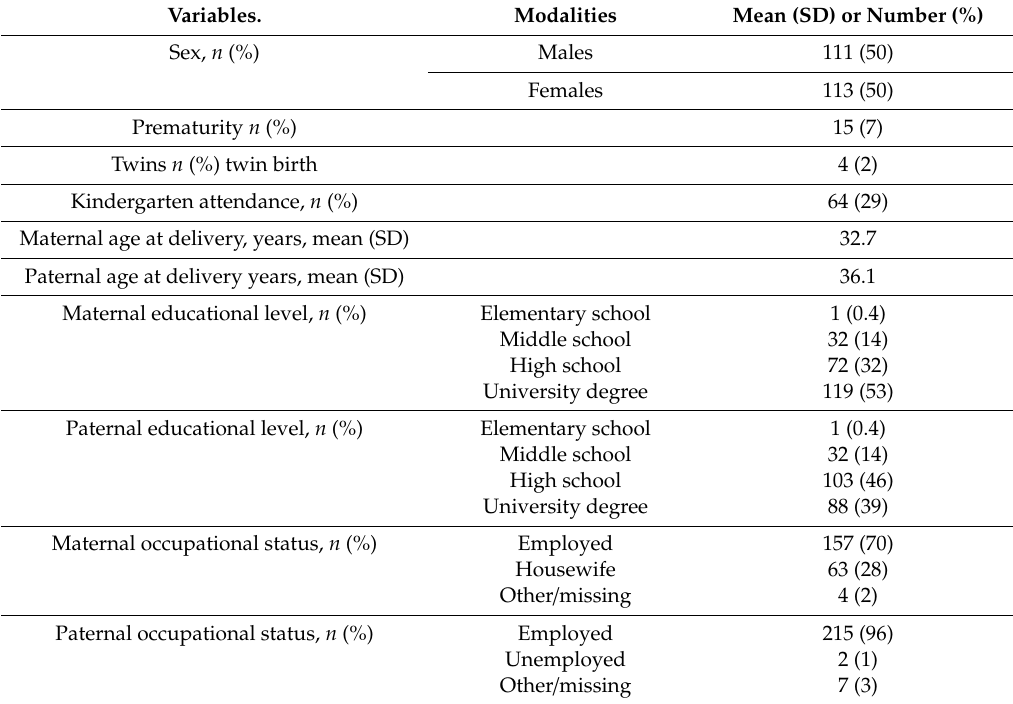
Table 1. Socio-demographic characteristics of the sample ( n =